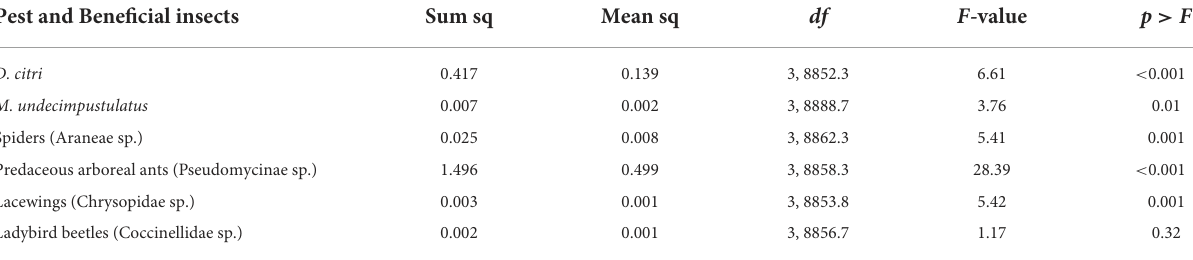
TABLE 3 Effects of four different economic threshold treatments on Diaphorina citri , natural enemies, and secondary pests in Florida